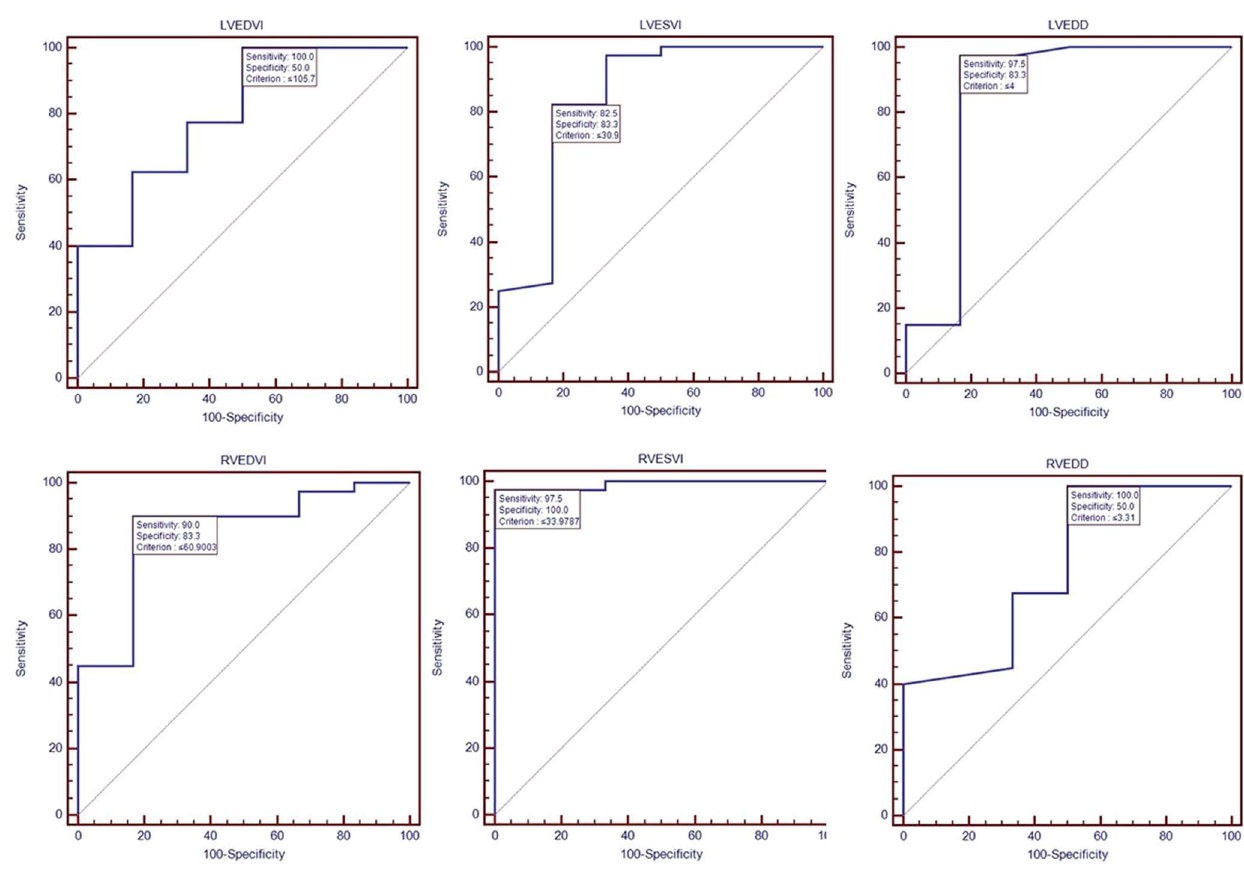
Figure 4. With ROC analyses, the sensitivity and specificity of RV and LV dysfunction and dimension on cardiac MRI for predicting HCM patients with severe heart failure (Class IV) were high.